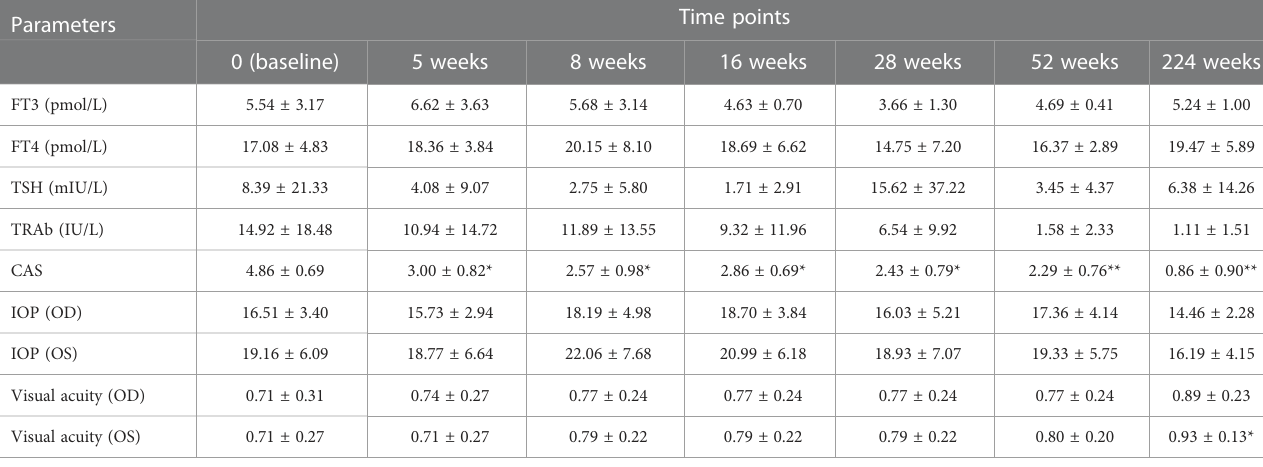
TABLE 3 Changes of clinical and laboratory parameters in TAO patients after rituximab treatment during the follow-up period.